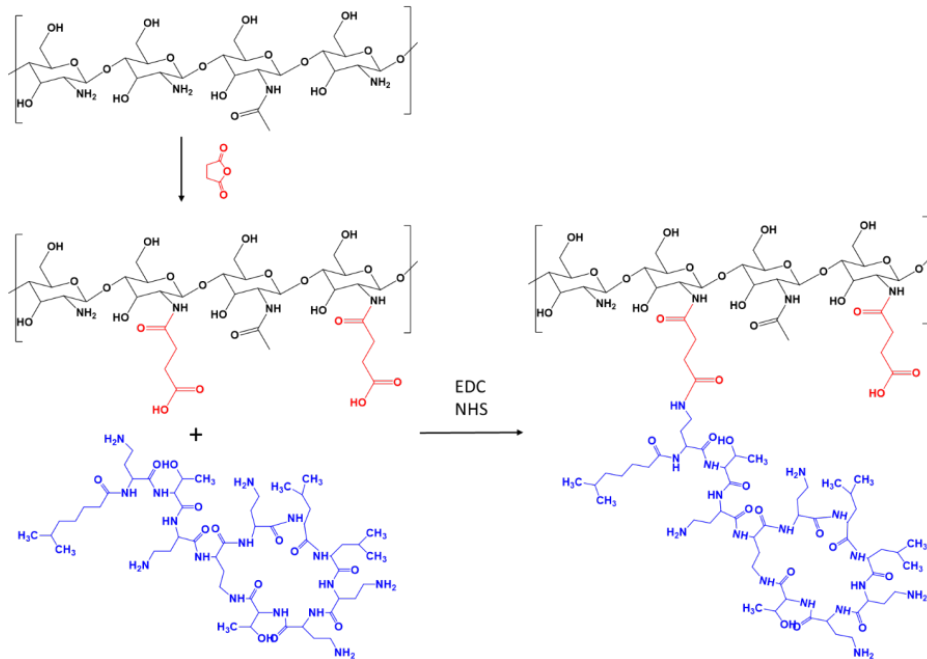
Figure 1. Synthesis scheme for succinyl chitosan-colistin conjugate (SucCS-CT). The DSs of SucCS-CT (Table 1) were calculated from the 1 H NMR spectra (Figure 2) using the CT multiplet signal at 0.74–0.88 ppm ( I 0.74–0.88 ) corresponding to 18 CT protons (Figures S1 and S2) by the following equation DS CT = I 0.74–0.88 . The signal of the methyl 18 I ( H − 1 ) protons of the SucCS acetamide group at 2.08 ppm was taken as a reference signal (0.78 H for CS with a degree of acetylation of